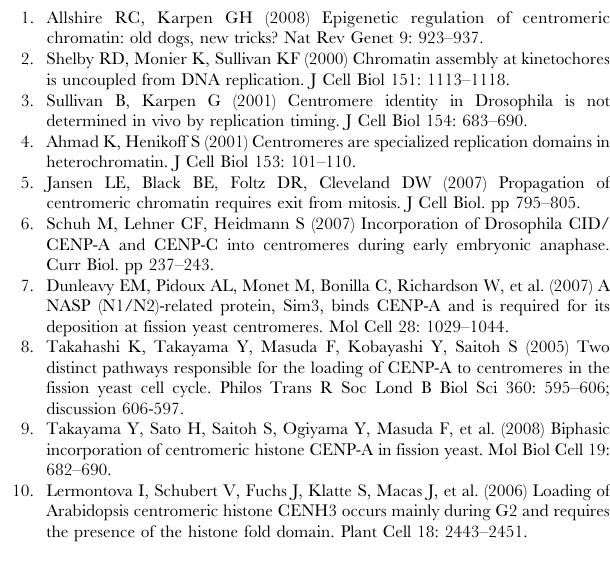
which show much weaker TMR-CID signal. ***p-value , 0.0001 for mitotic versus interphase positive cells (Fisher’s exact test). B) Representative images showing recruitment of TMR-CID (red) 1 h after the BTP-block. Centromeric TMR-CID is rarely observed in interphase (Inter), but it is visible in metaphase (Meta), anaphase/telophase (Ana/Telo) and cytokinesis/G1 (Cyto/G1). IF with anti-tubulin (green), anti-phospho H3 (gray), and DAPI (blue) was used to identify specific mitotic stages. Bar= 5 m m. Figure S7 Mitotic loading of SNAP-CAL1. Graphs showing the percent of cells containing new SNAP-CAL1 (y-axis) in interphase versus mitosis at 1, 2, 10, 24 h. Bars indicate standard error. Figure S8 New CENP-C is replenished during both mitosis and interphase in S2 cells. A) Percent of interphase and mitotic cells showing recruitment of new SNAP-CENP-C 10 h following the BTP block. New SNAP-CENP-C is equally detectable in both interphase (47%) and mitosis (48%), (p= 1 Fisher’s exact test). B) Representative image showing new SNAP-CENP-C recruitment in a mitotic cell in late anaphase/telophase (lower left), and an interphase cell (upper right). TMR-labeled CENP-C is shown in red, GFP-tubulin in green, phospho H3 in gray, and DAPI in blue. Bar = 5 m m.